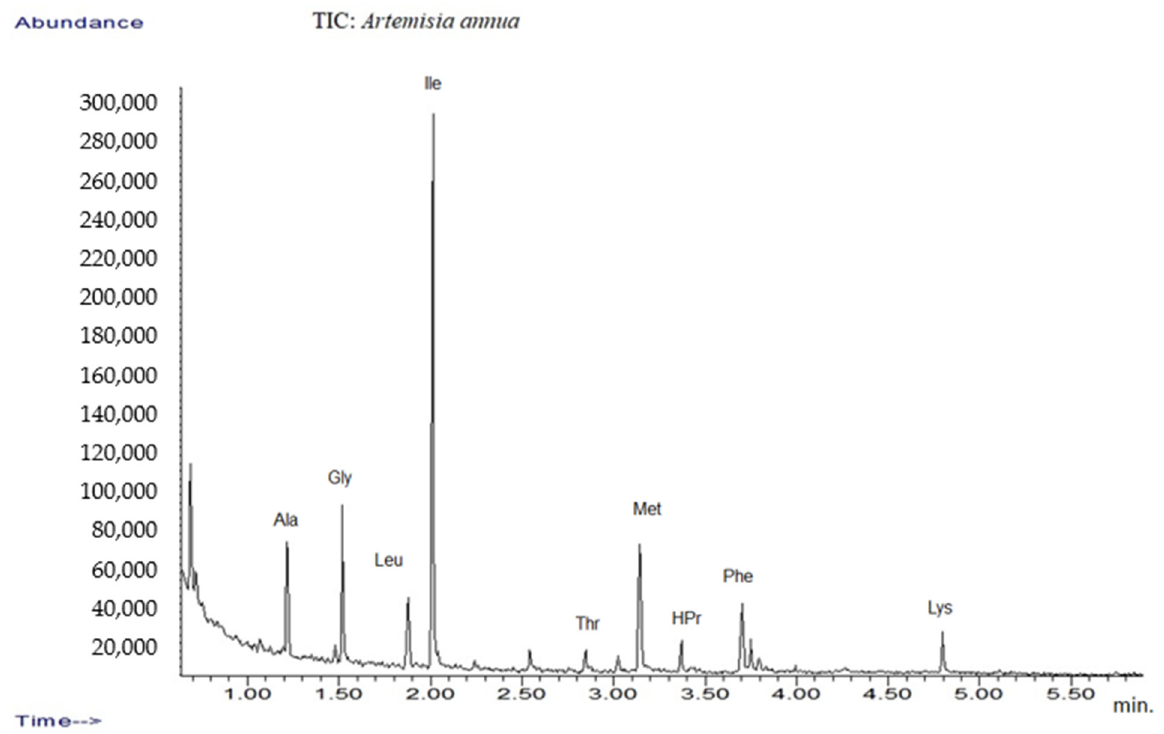
Figure 1. TIC chromatograms of GC-MS for Artemisia annua .